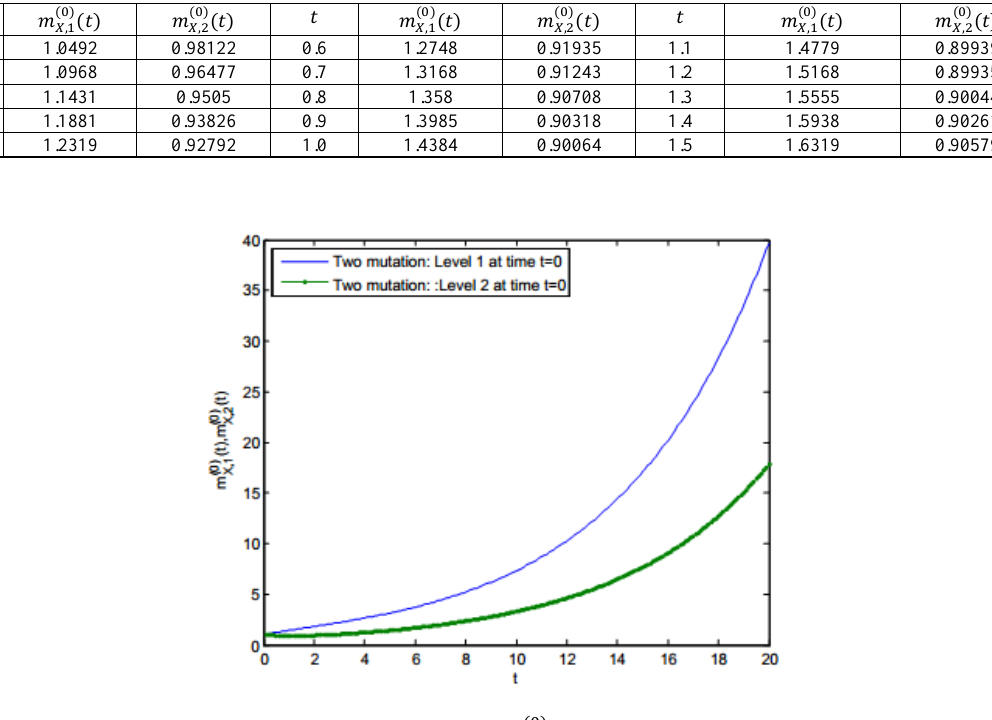
Figure 2. Graphs of 𝑚 𝑋,𝑗(0) (𝑡), 𝑗 = 1,2